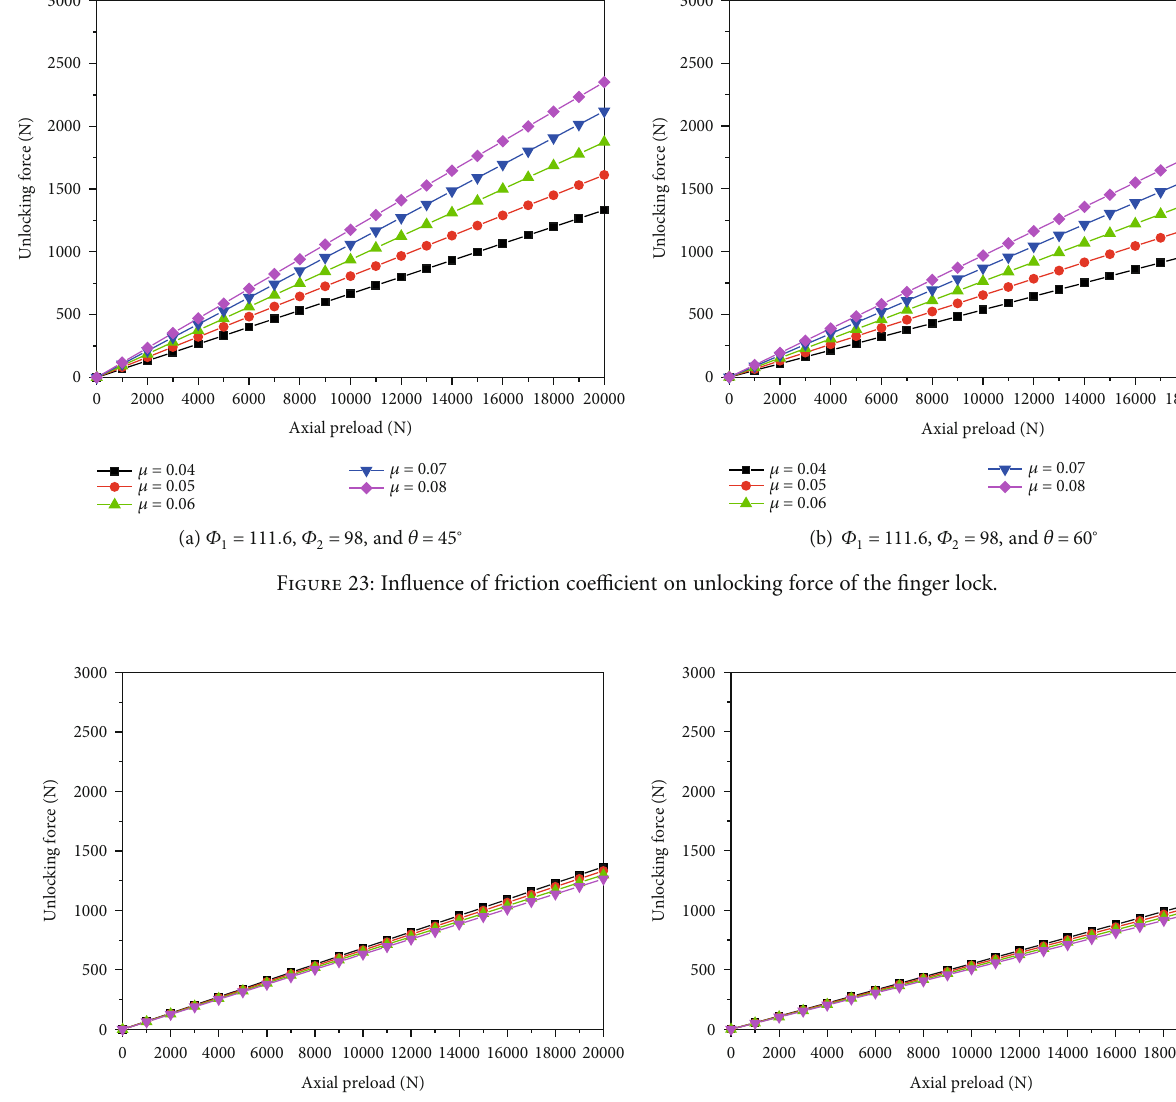
Figure 24: In fl uence of Φ